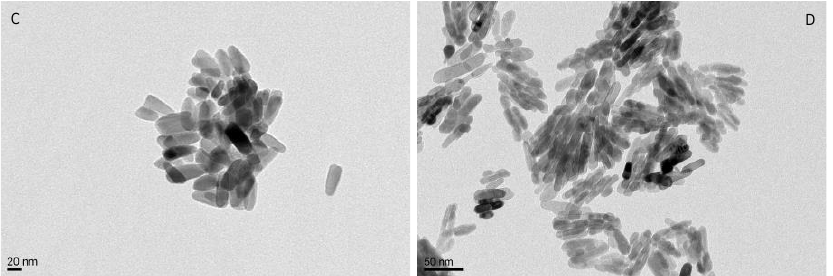
Figure 1. Comparison of structural, optical, and morphological properties: XRD patterns ( A ); and UV-Vis diffuse reflectance spectra ( B ) of MW-A (anatase) and MW-R (rutile TiO 2 ) samples. Panel ( C ) and ( D ) show the TEM images of MW-A and MW-R,